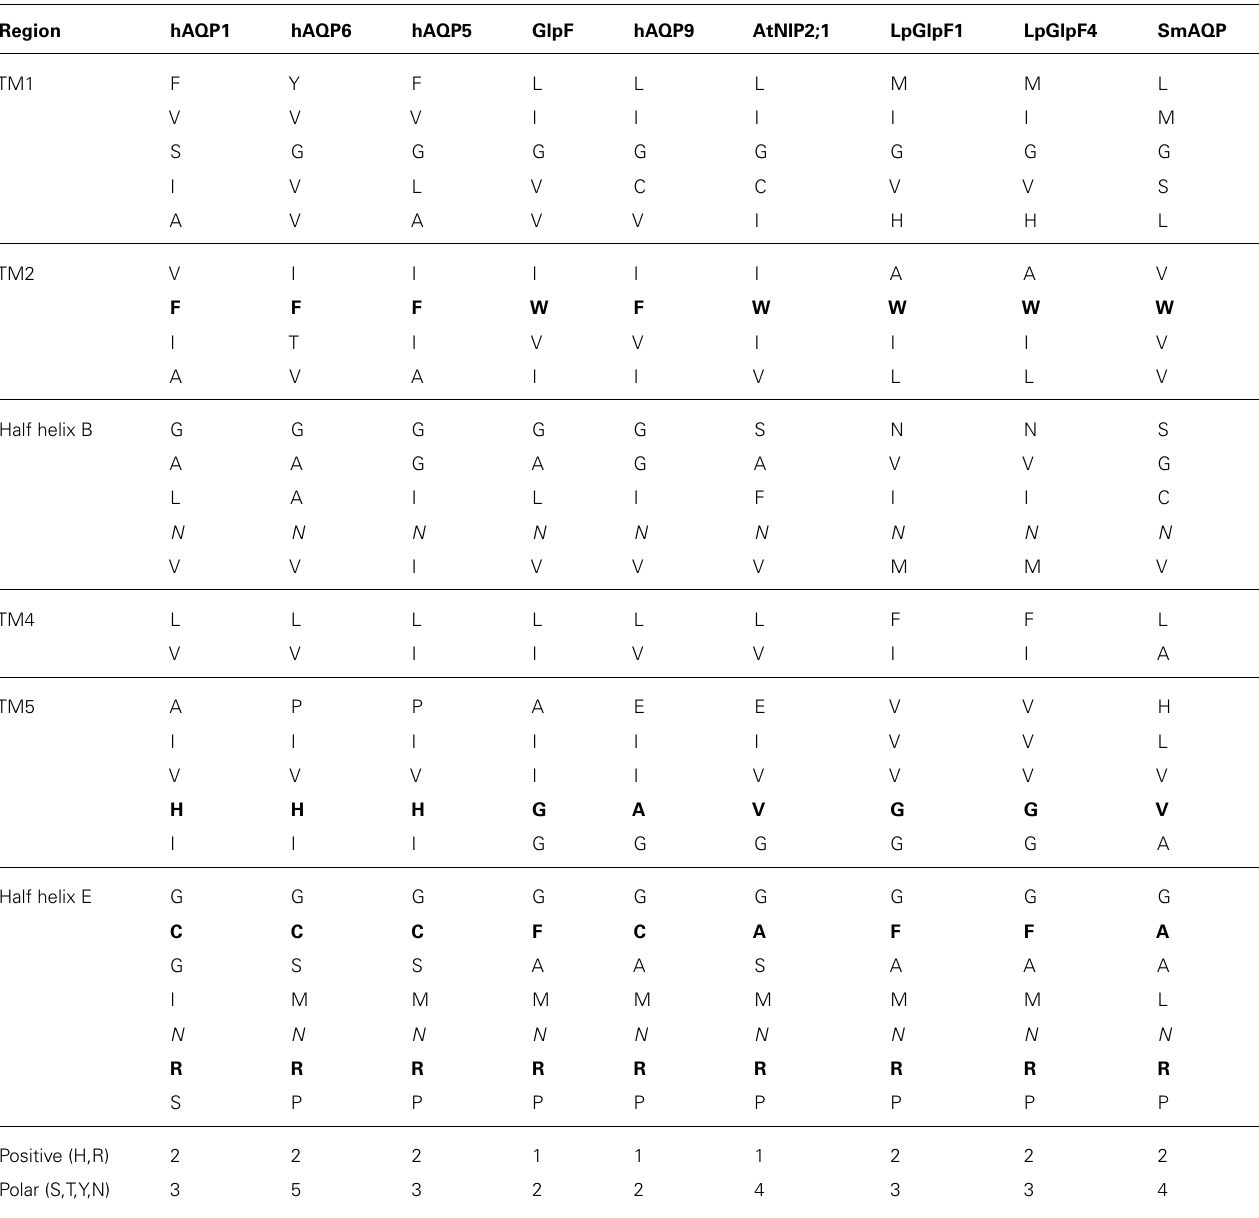
Table 1 | Pore lining amino residues of selectedAQPs. Region